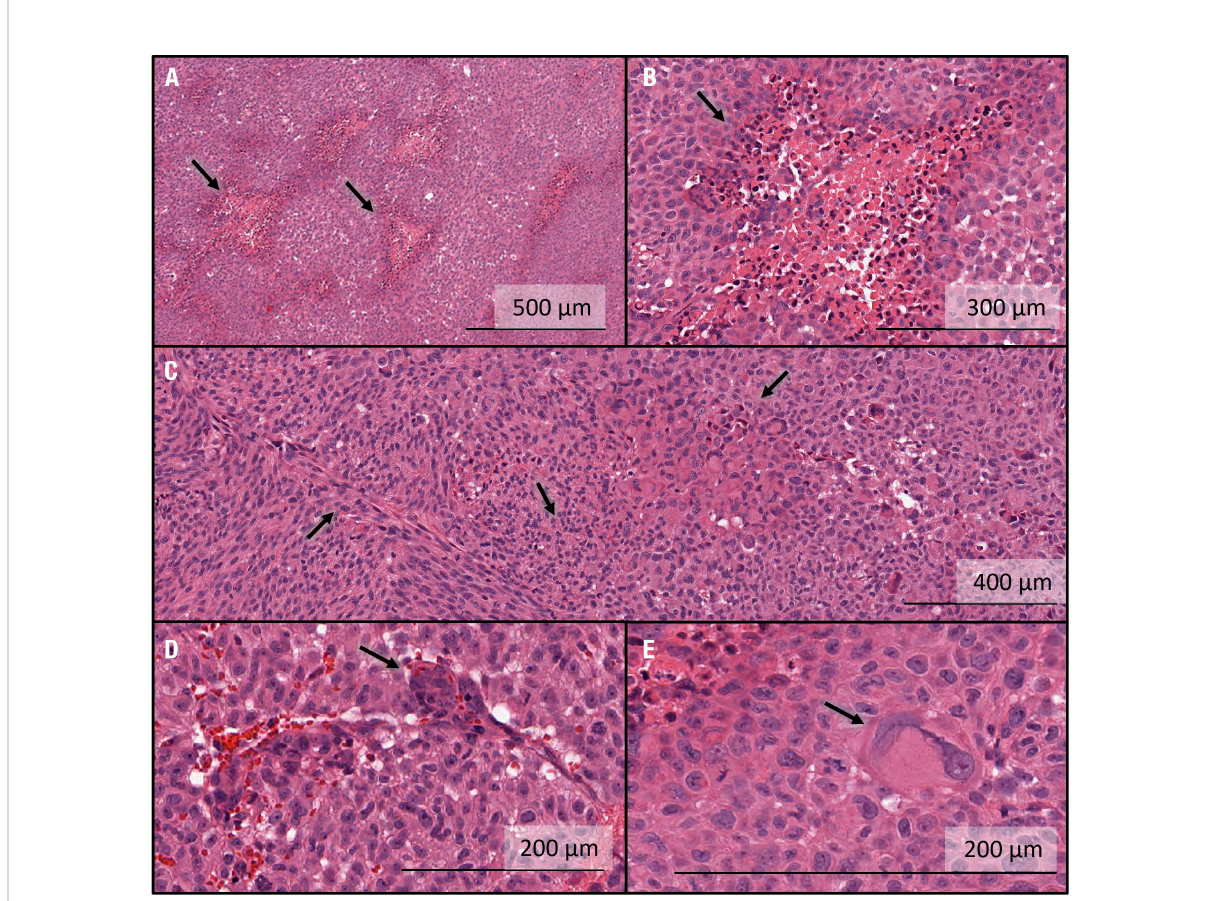
FIGURE 5 Histological characterization of intracranial GBM10 tumors in Rag2 -null rats, based on H&E staining. (A) Multiple regions show high-density cell networks surrounding a centrally pink-stained area, indicating a rudimentary version of pseudopalisading with necrosis characteristic of human GBM tissue. (B) High-resolution image showing pseudopalisading with necrosis. The lighter pink areas with lower cell density show some degree of necrosis and are surrounded by cells with darker nuclei, again showing rudimentary pseudopalisading with necrosis. The morphology is not exactly similar to that seen in humans, where the tumors can grow for much longer than in rats. (C) Examples of an array of marked cellularity with hyperchromatism and pleomorphism. Note the variety of cell morphologies, from fl at mesenchymal tumor cells (left-hand side) to giant anaplastic cells (right-hand side) and mitotic fi gures (middle). (D) Example of endothelial proliferation, another important feature of GBM. Glomeruloid vessel formation and endothelial multilayering secondary to endothelial hyperplasia are shown here. These changes are related to the tumoral secretion of vascular endothelial growth factor to overcome hypoxic conditions. These examples were less numerous here than typically seen in human GBM tissue. (E) Multinucleate giant cells with bizarre hyperchromatic nuclei are referred to as giant cell astrocytoma and present in some forms of human